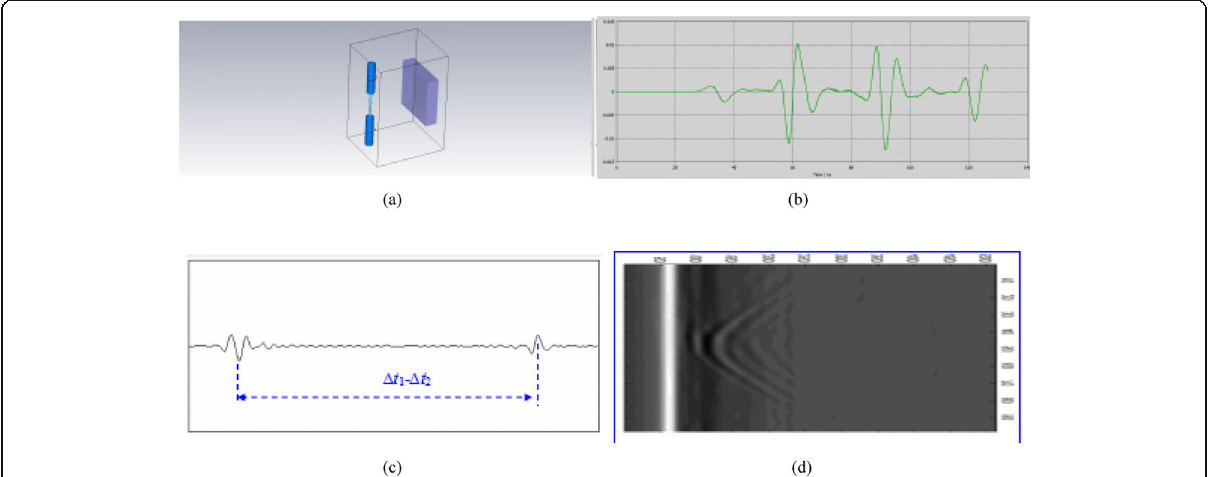
Fig. 2 Target echo signal and imaging diagram. a CST simulation calculation model for target echo signal. b CST simulation calculation results for target echo signal. c Experimental test results for interface echo signal. d Target position and shape diagram after DC and noise wave